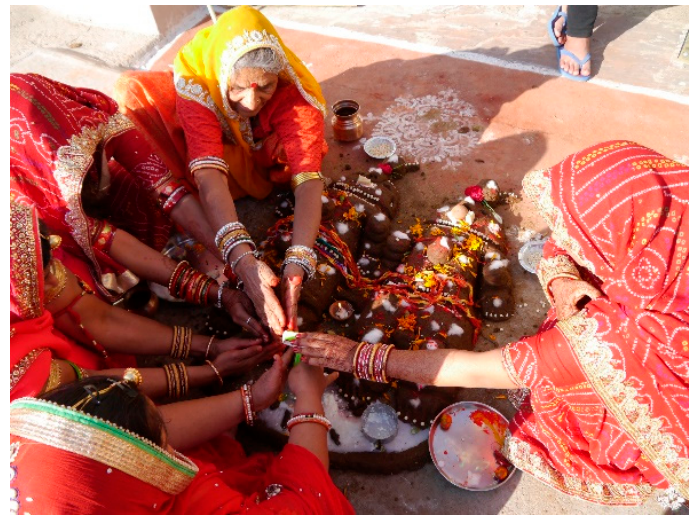
Figure 16. Women doing the Govardhan puja together, Badi 2017 (picture by author).